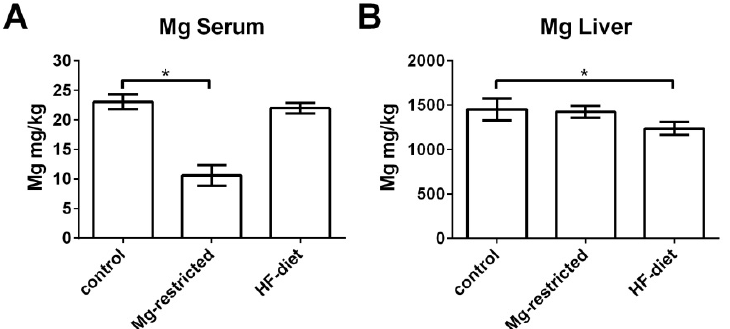
Figure 1. Serum and liver Mg-concentrations in control, Mg-restricted, and HF-diet fed mice. Mg-content was measured with ICPMS resulting in ( A ) significant reduced serum Mg-concentrations in Mg-restricted mice compared to control mice. ( B ) Hepatic Mg-content is not reduced in Mg-restricted mice, while HF-diet feeding results in significantly lower liver Mg-content as compared to control mice. Depicted are means with standard deviations and P values of < 0.05 are marked by an * (one-way ANOVA followed by Dunnett’s multiple comparisons test).